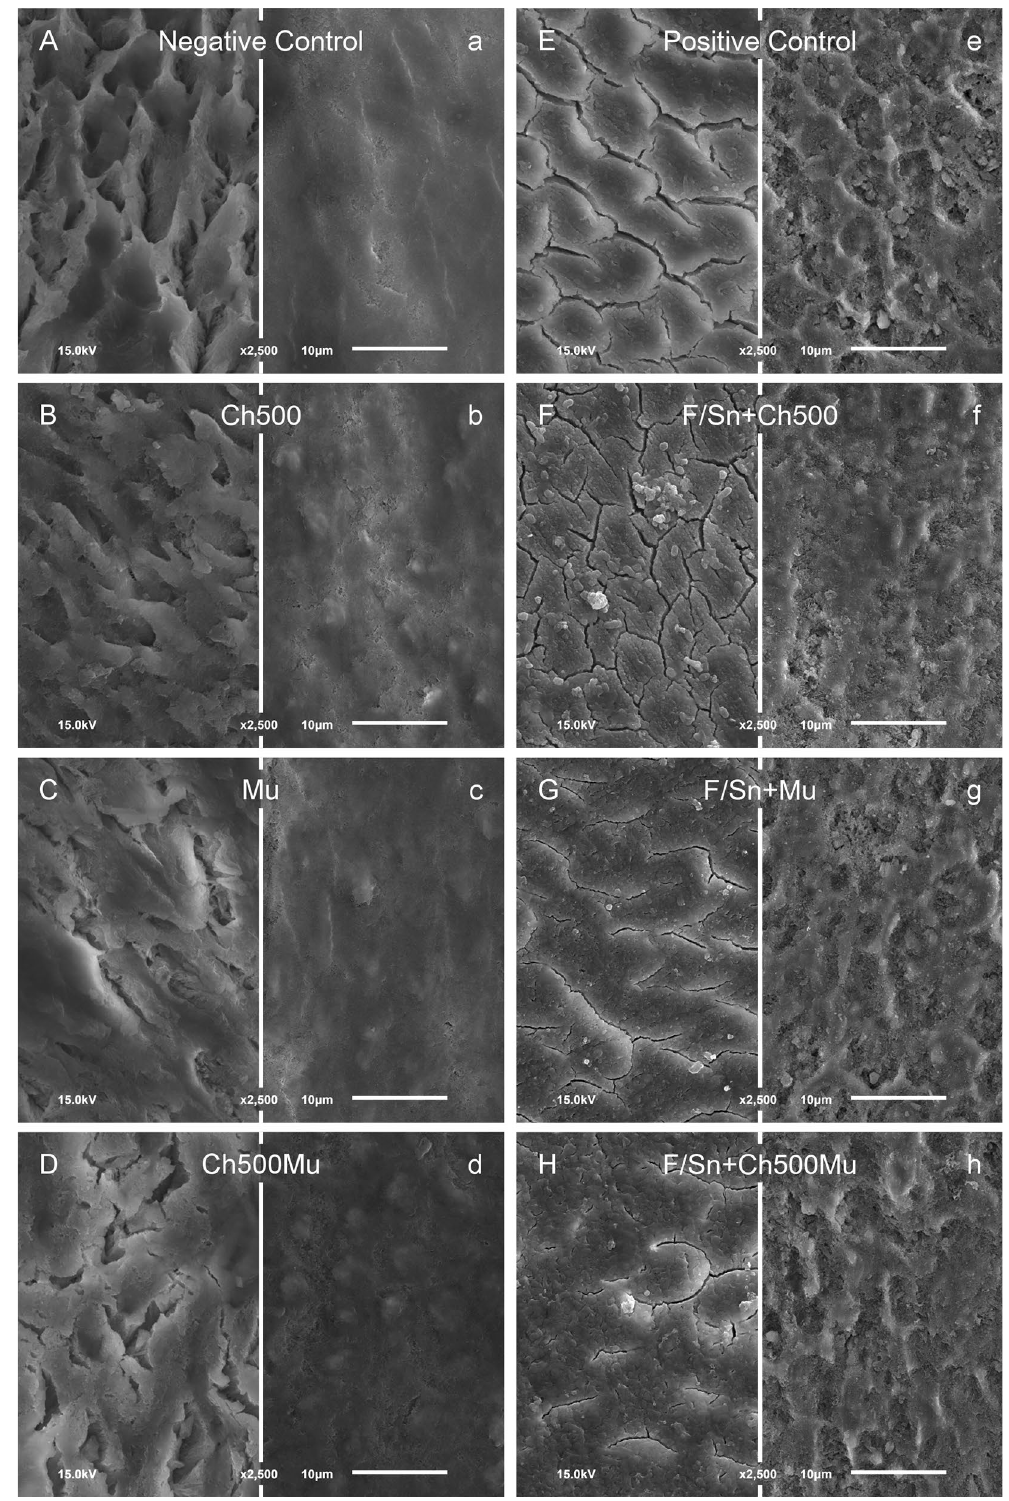
Figure 3. SEM images of selected samples. The left column ( A – D / a – d ) depicts samples from experiment 1 without application of F/Sn, the right column ( E – H / e – h ) depicts samples from experiment 2 with application of F/Sn. Samples under erosive conditions are marked with capital letters, samples under erosive-abrasive conditions are marked with lowercase letters. Negative Control = without active agents; Positive Control = F/Sn only; Ch500 = chitosan with viscosity 500 mPas; Mu = porcine gastric mucin; Ch500Mu = treated with Ch500 and Mu; F/Sn = additional application of F/Sn (original magnification: